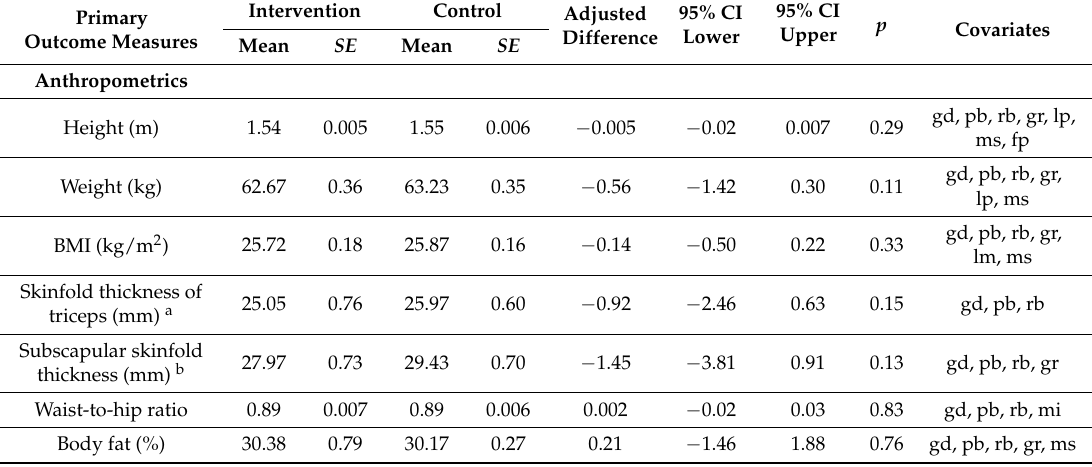
Table 2. Estimates of anthropometrics impact in complex sample general linear model.